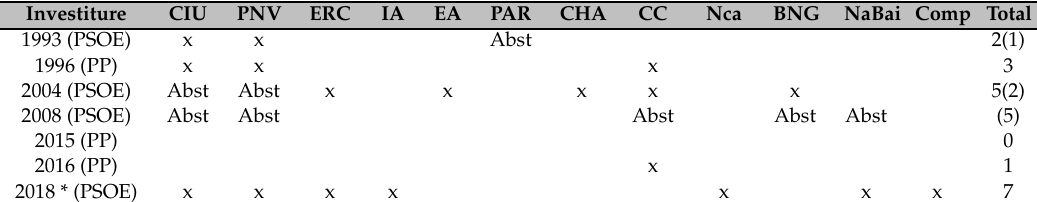
Table 1. Support received from regional nationalist parties in the investiture processes of governments in Spain, 1993–2018.